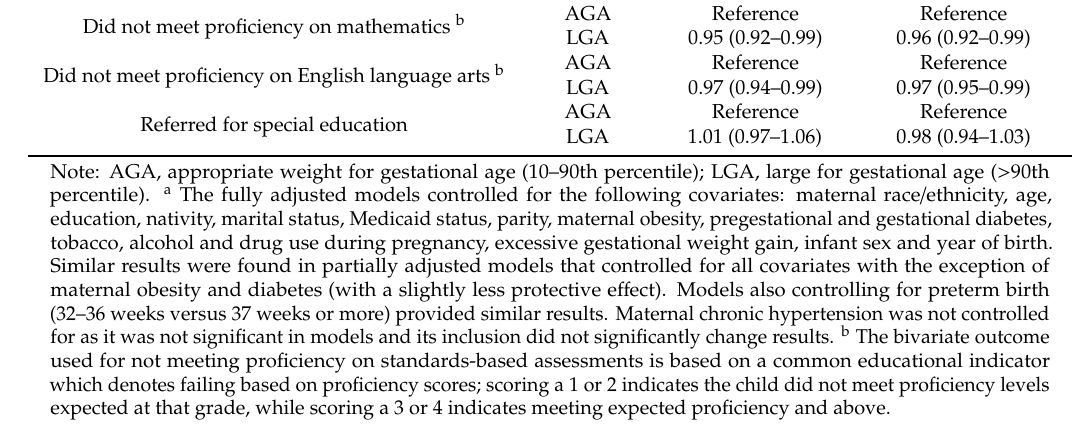
Table 2. Relative risks for long-term academic outcomes and delays for children born LGA ( n = 108,348). Outcome Category Unadjusted RR Fully Adjusted RR a AGA Did not meet proficiency on mathematics b